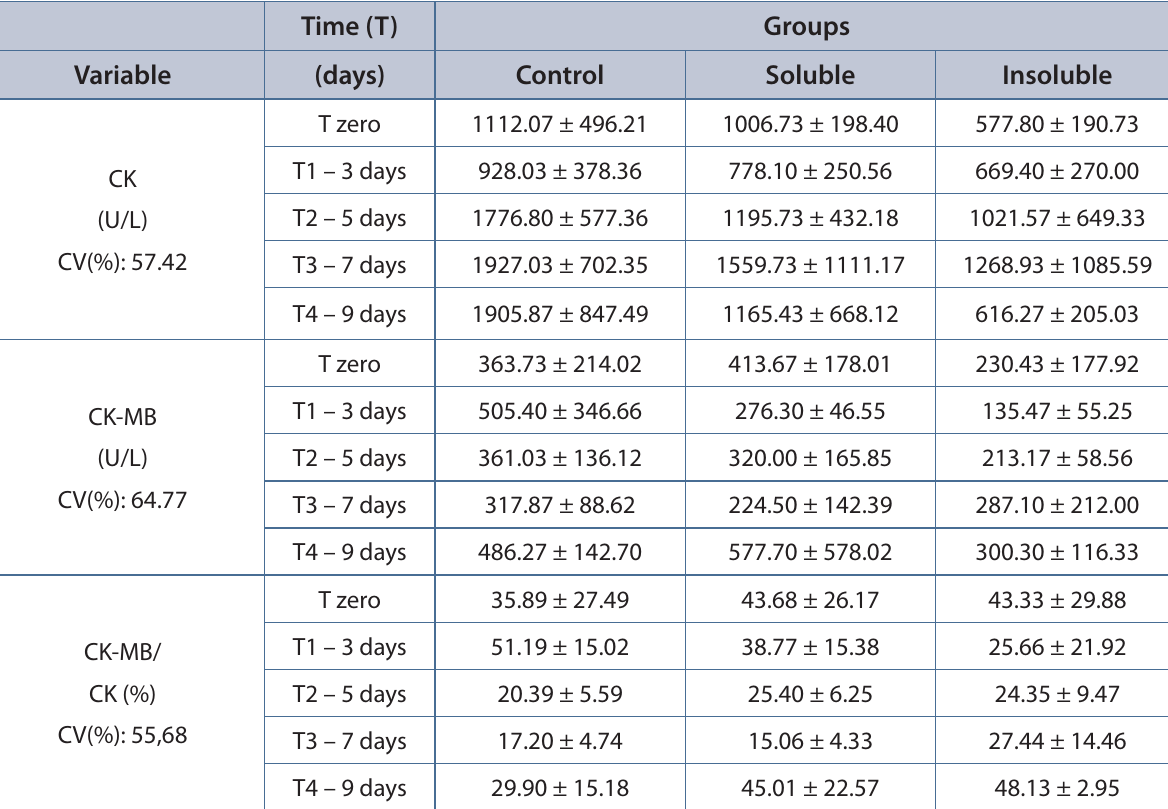
Table 2. Mean serum levels of creatine kinase* (CK – U/L), MB creatine kinase fraction* (CK-MB – U/L) and relative percent of CK-MB* (CK-MB/CK - %) in rabbits submitted to gavage with ultra-pure water (CG), water- soluble A. rigida extract (SG) and water-insoluble A. rigida extract (IG) at different